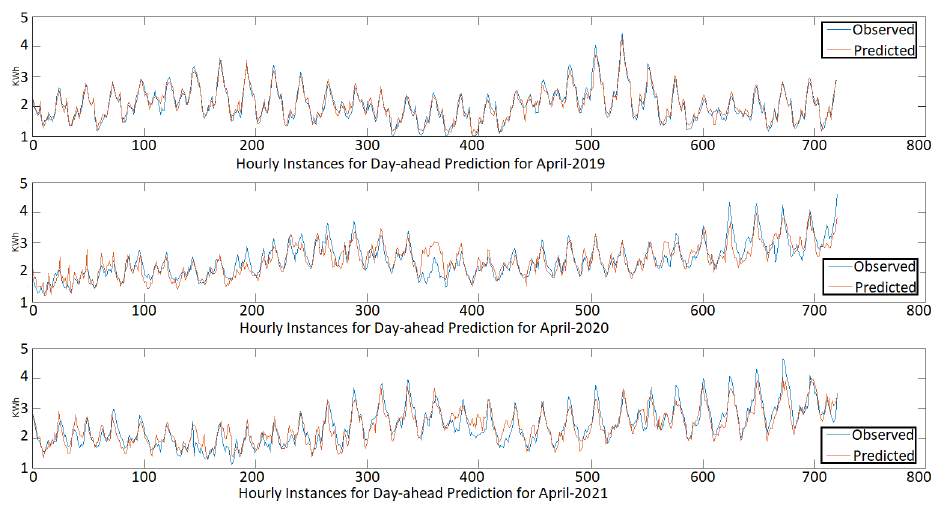
Figure 20. SVR-based forecast models for April’s day-ahead prediction for the AC-included category over 3